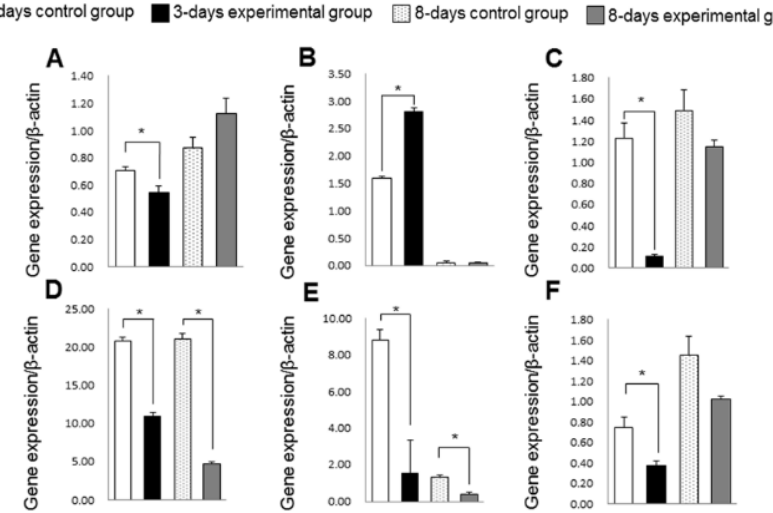
Figure 8. Gene expressions of matrix metalloproteinase-3 (MMP-3) ( A ); tissue inhibitor of metalloproteinase-1 (TIMP-1) ( B ); nuclear factor-κB (NF-κB) ( C ); interleukin-1β (IL-1β) ( D ); tumor necrosis factor-α (TNF-α) ( E ); heme oxygenase-1 (HO-1) ( F ) in rats. Bars represent means ± SD of 6 rats. * p < 0.05 compared with control